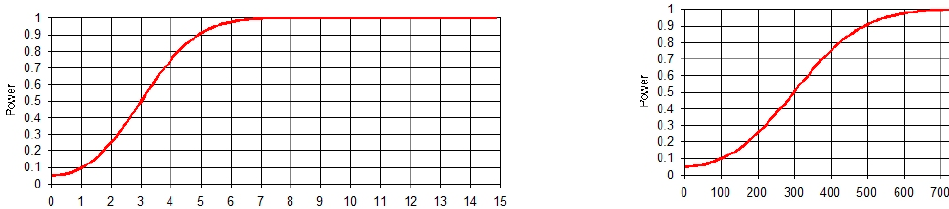
Figure 3. Sample size calculation to determine power to detect significant differences in pelvic bones D mean (Gy ( left ) and bowel mean V 15Gy (cc) ( right ) when comparing IMPT and IMRT/VMAT.